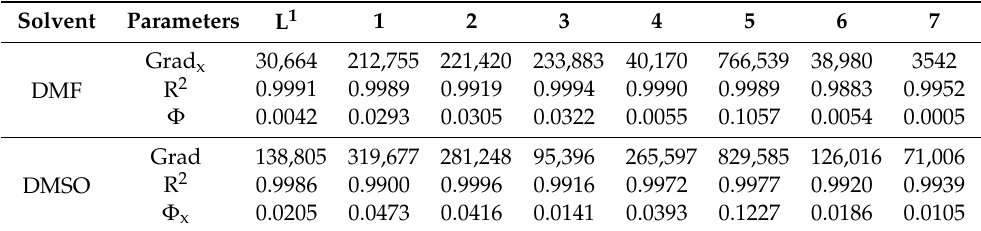
Table 4. The fluorescence quantum yields of the complounds in solution a .